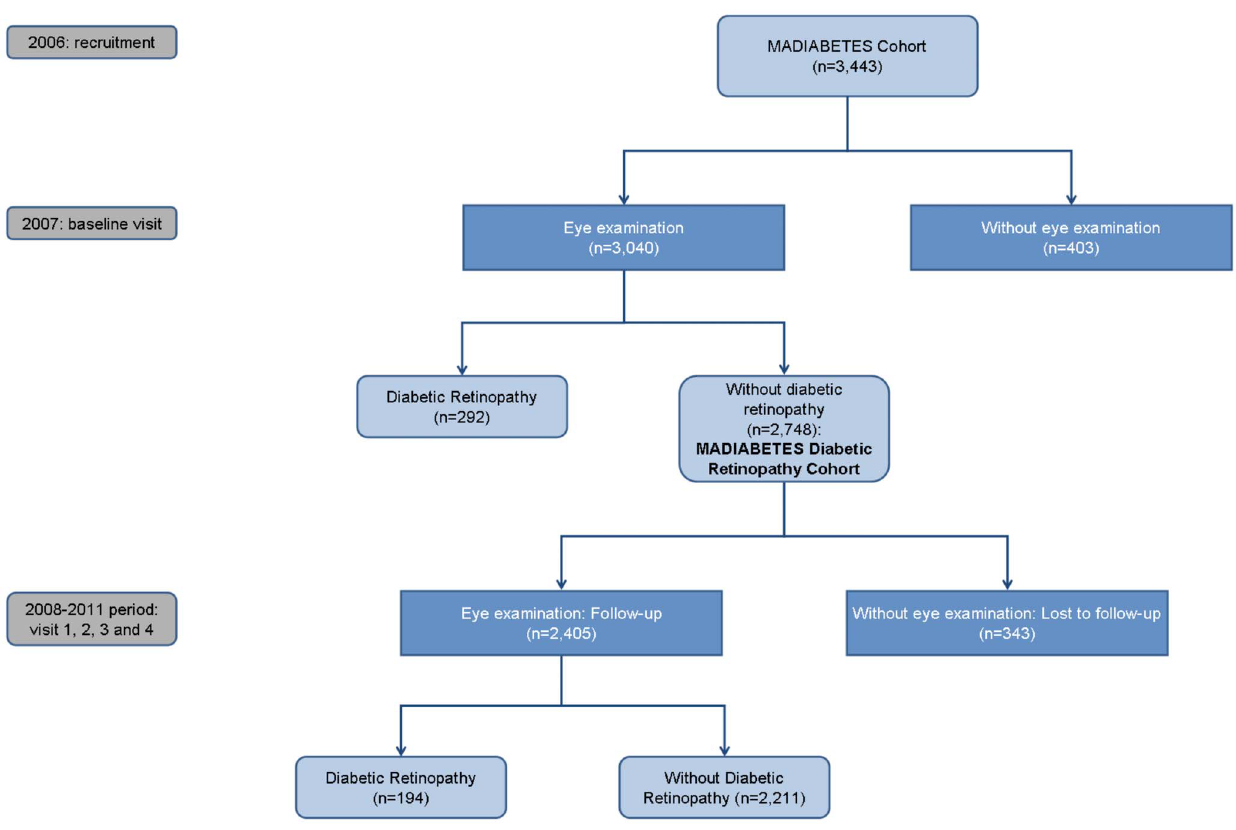
Figure 1. Flow diagram of the MADIABETES cohort.